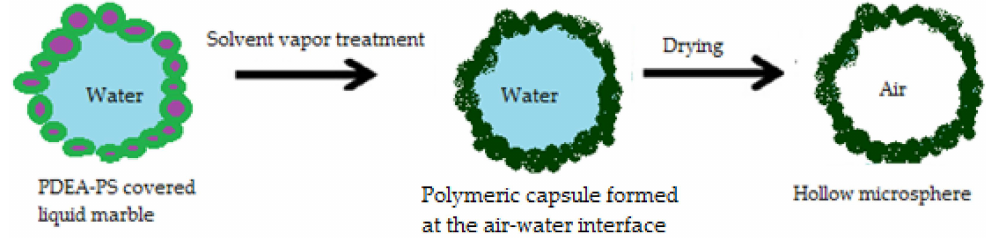
Figure 14. Transformation of a liquid marble into a